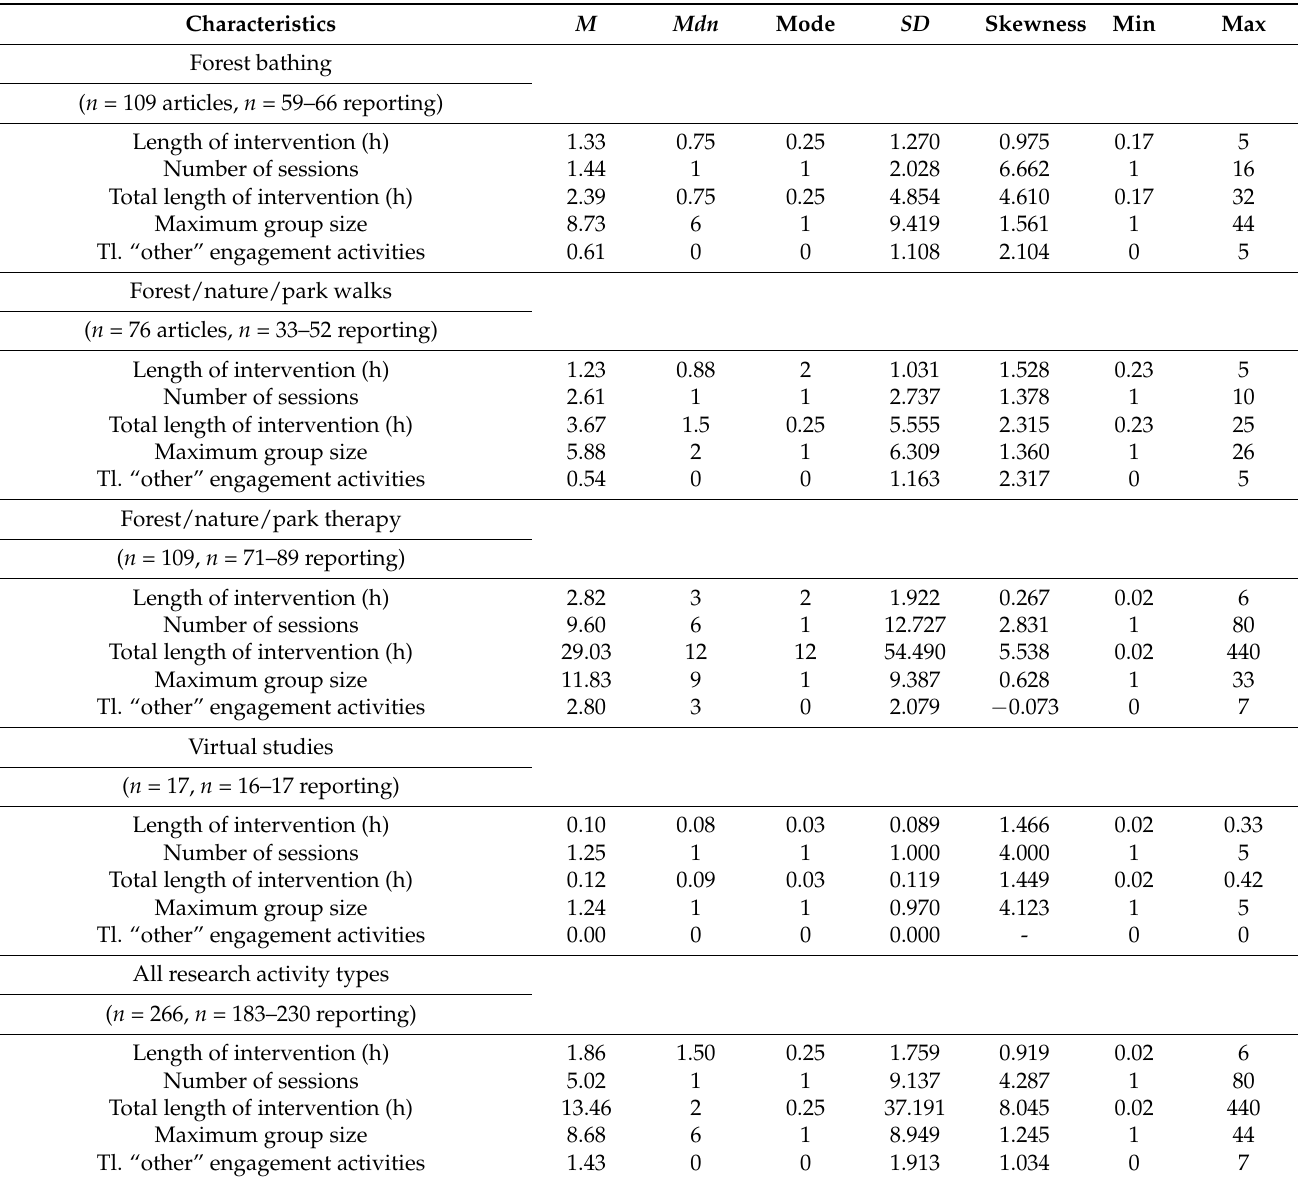
Table 8. Summary characteristics of interactions for different research activity